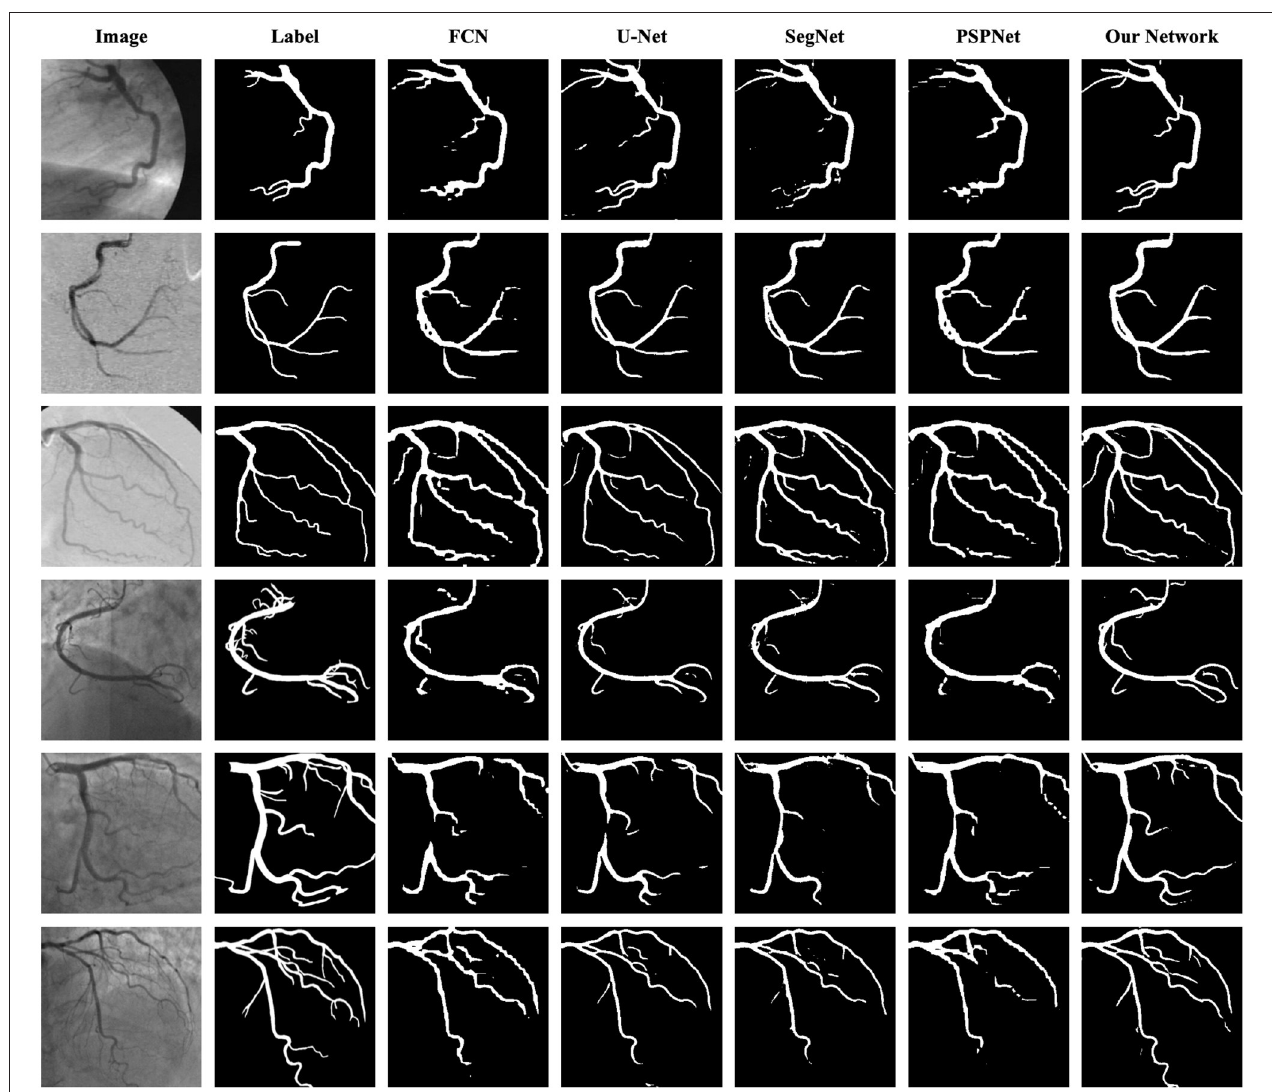
FIGURE 10 | Segmentation results of FCN, U-Net, SegNet, PSPNet, and the proposed network. The images in the first column are the original angiograms, while the corresponding labels are in the second column. The images in the first three rows are from DCA1, the same dataset as the training set, while the images in the last three rows are from